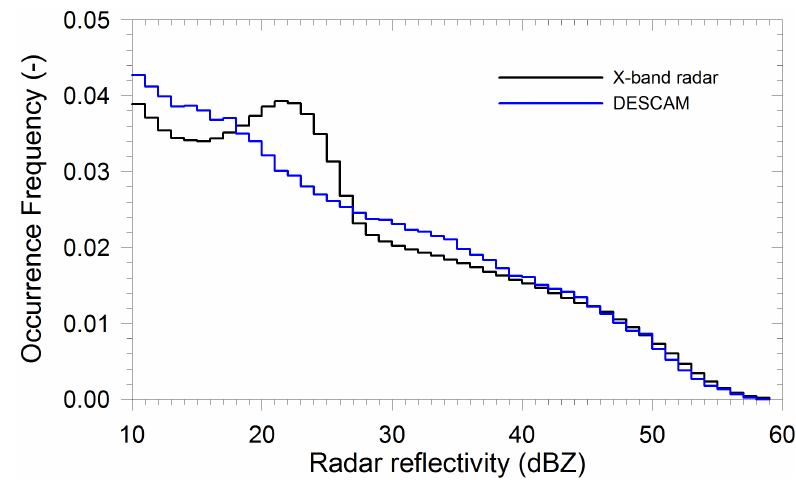
Figure 5. Probability density function of the X-band radar observations from 06:40 to 10:40 UTC and modelled with DESCAM over the same period every 20